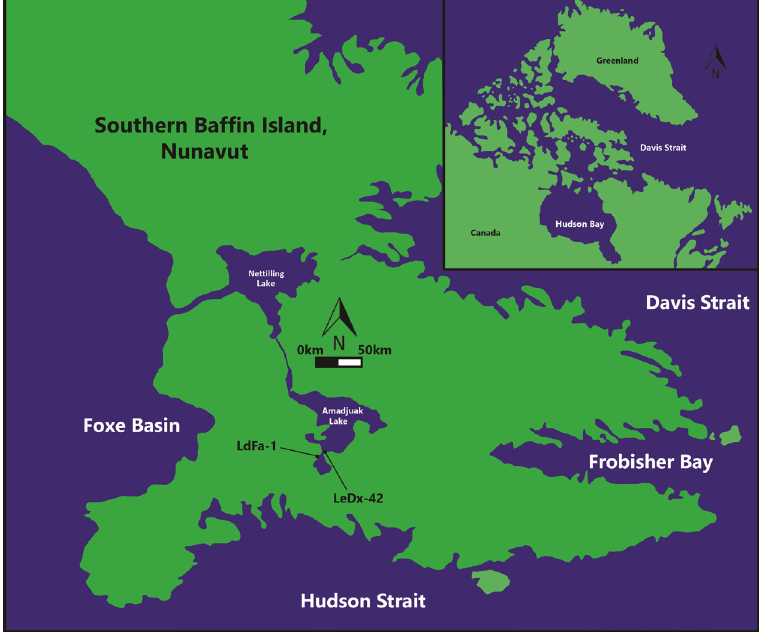
Figure 1: Archaeological sites LdFa-1 and LeDx-42 situated on a Google Earth landsat image with southern Baffin Island inset. Sites are located near lakes Mingo and Amadjuak, southern Baffin Island,